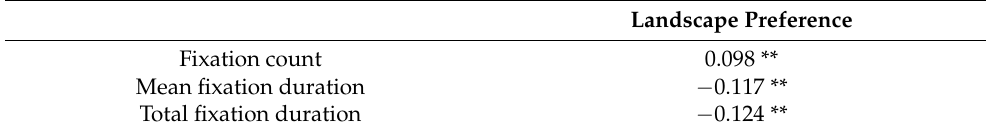
Table 6. Comparison of men and women, professional and non-professional on landscape perceptions and preferences, based on a Mann-Whitney